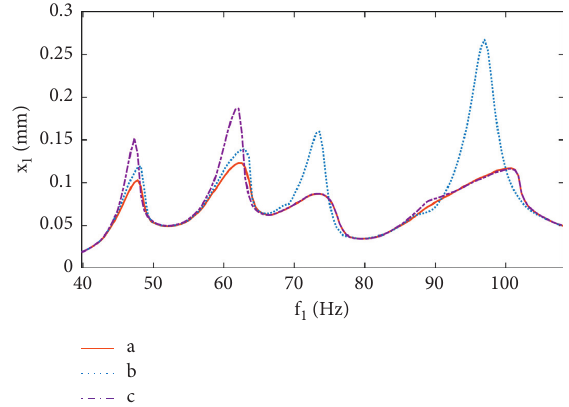
Figure 17: Comparisons of different SFD implemental configu- rations (a: two SFDs, b: one rear low-pressure SFD, c: one front high-pressure SFD).